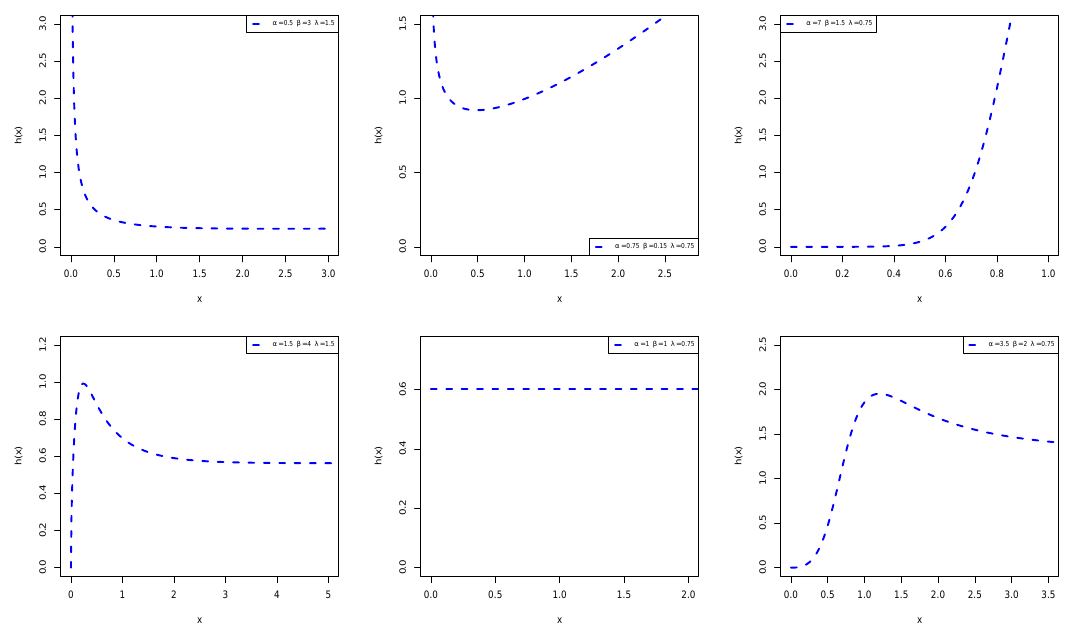
Figure 2. Different possible shapes of the EOWE hazard function for several parametric